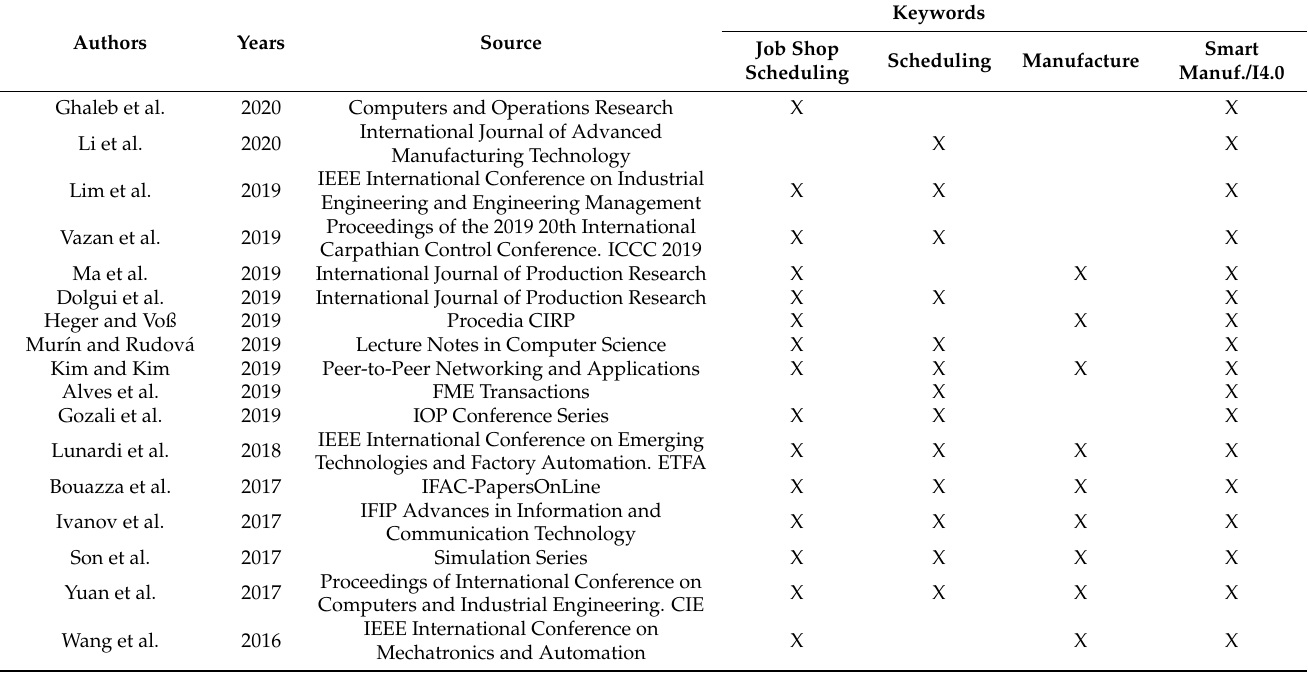
Table 2. Documents by keywords (source: